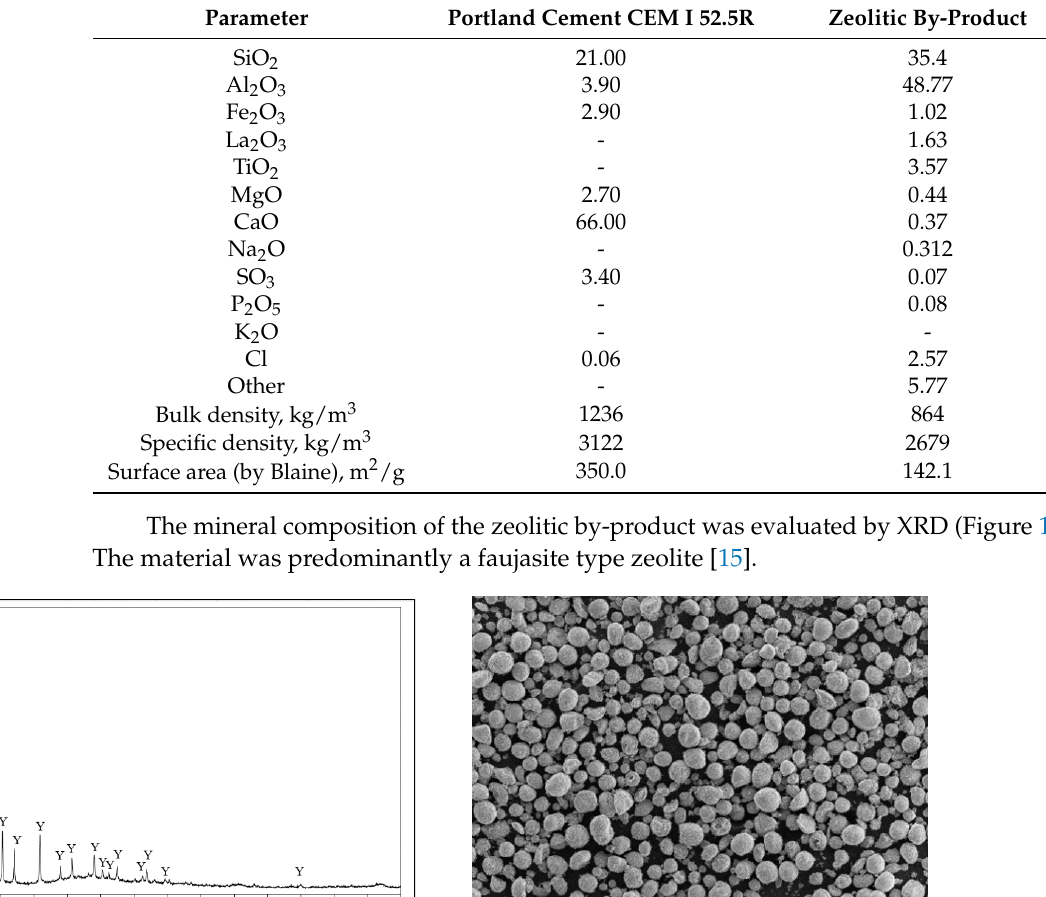
Table 1. Chemical composition of ordinary Portland cement and zeolitic by-product, % (by X-ray fluorescence (XRF) analysis.